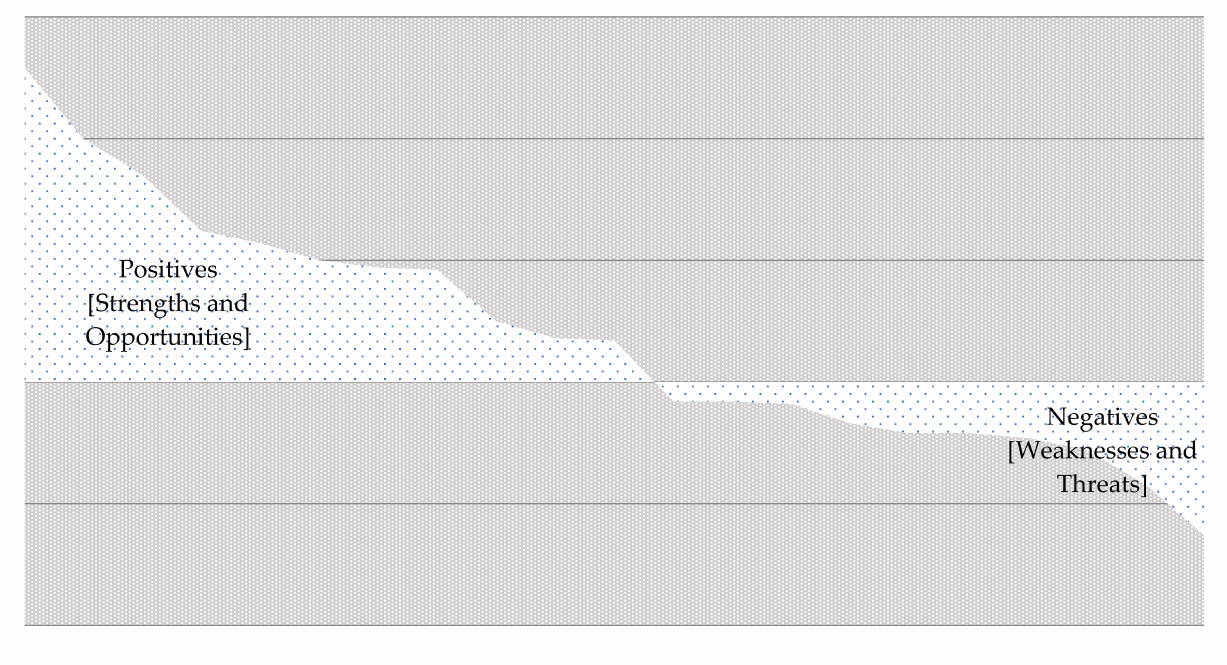
Figure 5. Positive versus negative indicators in a graphic